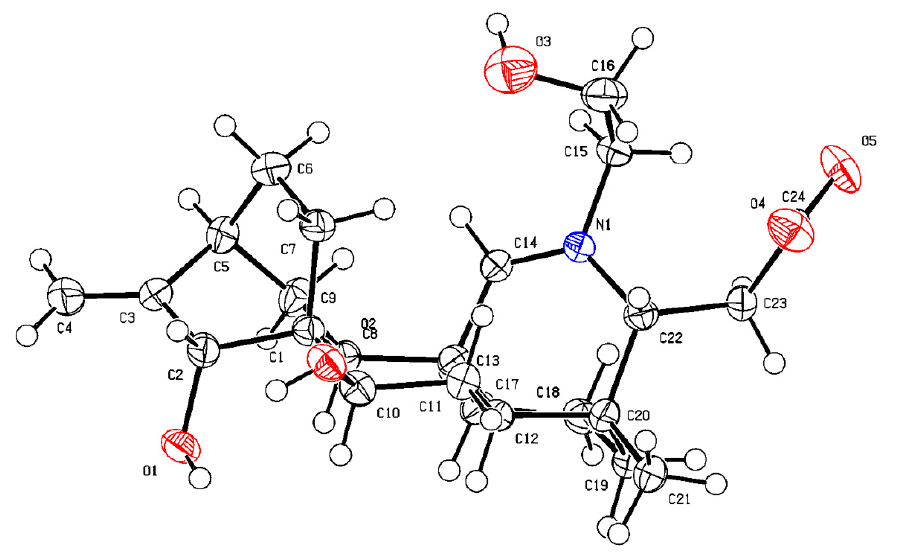
Figure 3. ORTEP drawing of compound 4 .